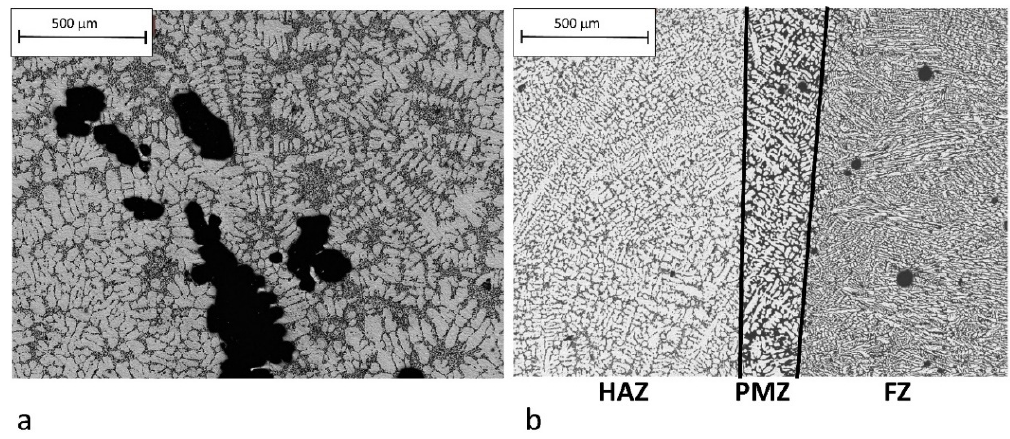
Figure 7. ( a ) Microstructure of the EN AC 42100-T6 alloy, 50 × ; ( b ) Microstructure present at the fusion zone (FZ) / cast component interface, 50 × .